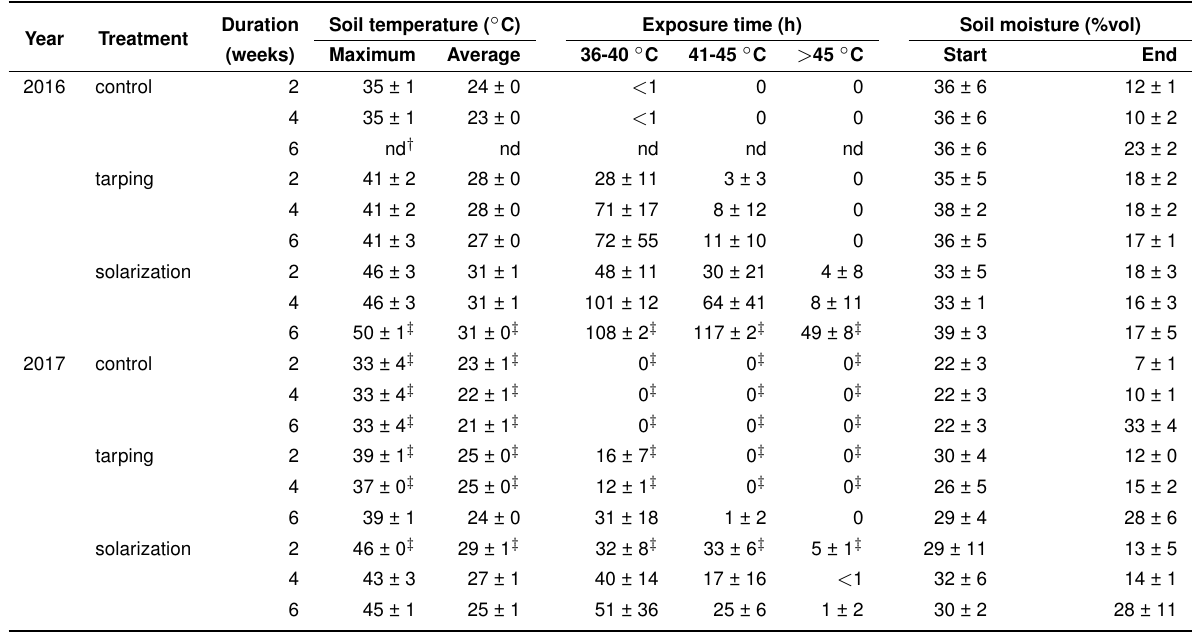
Table 4. Mean ± SD maximum and average temperatures, exposure time to temperatures greater than 35 ◦ C, and volumetric soil moisture measured during TARP experiments.